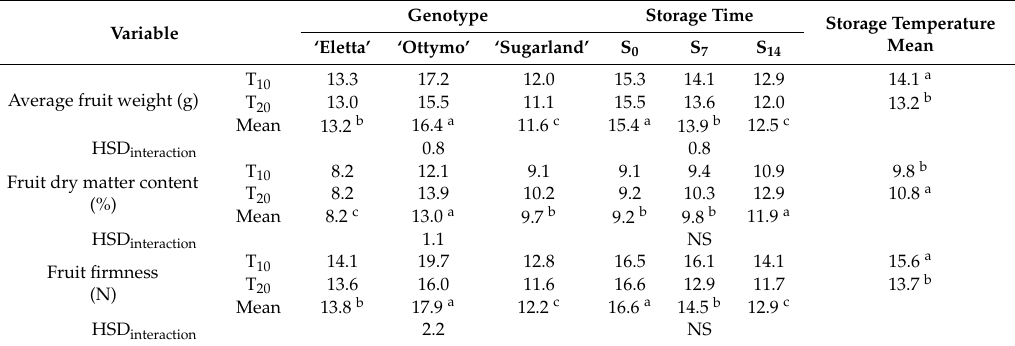
Figure 1. Average fruit weight ( A ), fruit dry matter ( B ), reducing sugars content ( C ), SSC/TA ( D ) and Δ E * ab ( E ) as affected by ‘genotype × storage time’ interaction. Black bars: S 0 ; grey bars: S 7 ; white bars S 14 . Table 3. Carpometric variables of cherry tomato as a ff ected by the main